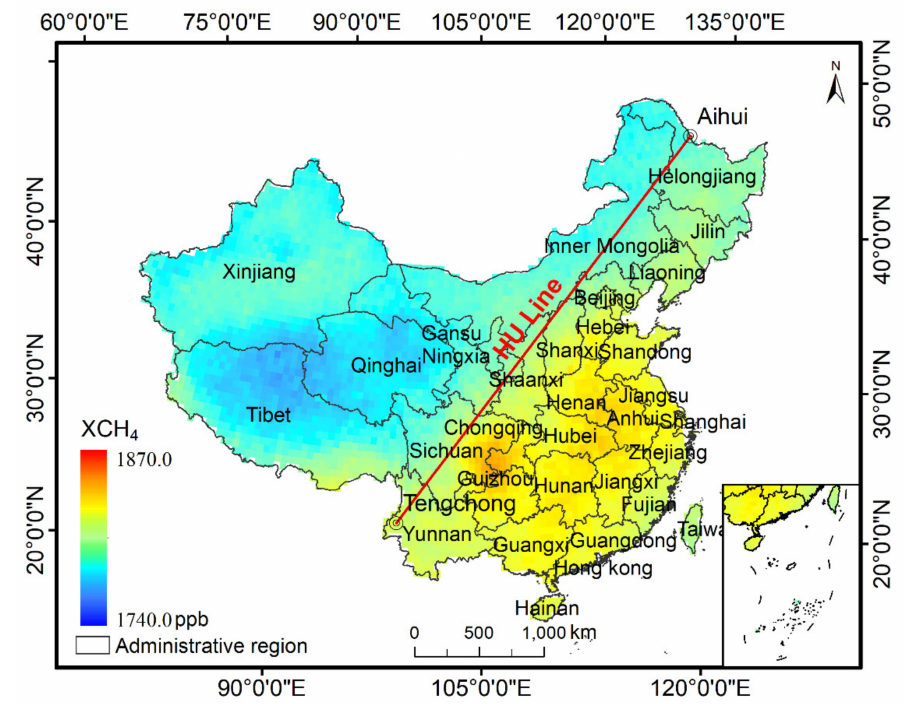
Figure 7. Spatial distribution of the annual mean XCH 4 concentration over all of China from 2003 to